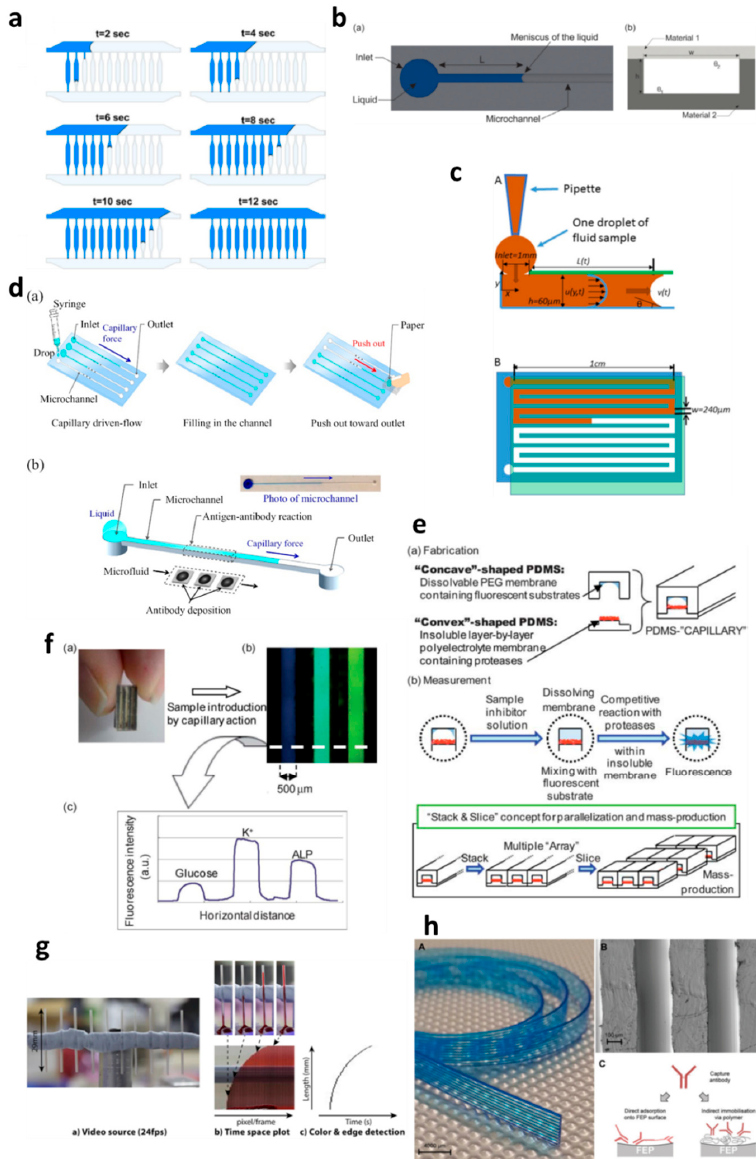
Figure 2. Applications of capillary-driven flow microfluidics. ( a ) computational fluid dynamics (CFD)-modelled filling of microchannels at multiple time points. Reproduced with permission from [28]; ( b ) Optical viscometer. Schematic of the microchannel with the capillary flow ( a ), illustration of the microchannel fabrication with two different substrates ( b ). Reproduced with permission from [29]; ( c ) Capillary flow pressure-driven zebrafish-blood-loaded microchannels. Side and top view of the sample pipetting and fluid flow in the microchannel ( A , B ). Reproduced with permission from [30]; ( d ) Illustration of the antibody immobilization process ( a ) with single-channel schematic ( b ). Reproduced with permission from [33]; ( e ) Combinable-polydimethylsiloxane (PDMS) capillary sensor array concept illustration. Reproduced with permission from [34]; ( f ) Combinable-PDMS capillary sensor array analysis of serum components via imaging ( a ) and fluorescence microscopy (b-c). Reproduced with permission from [35]; ( g ) Blood volume collection using glass capillaries. Capillary filling with EDTA blood ( a ) with the capillary filling plot of time − space ( b ) and color threshold levels and edge detection ( c ). Reproduced with permission from [41]; ( h ) Fluoropolymer microcapillaries illustration with flat ribbon blue dye-filled ( A ), field emission gun scanning electron microscopy (FEG-SEM) image ( B ), and capture antibody immobilization strategies ( C ). Reproduced with permission from [42].